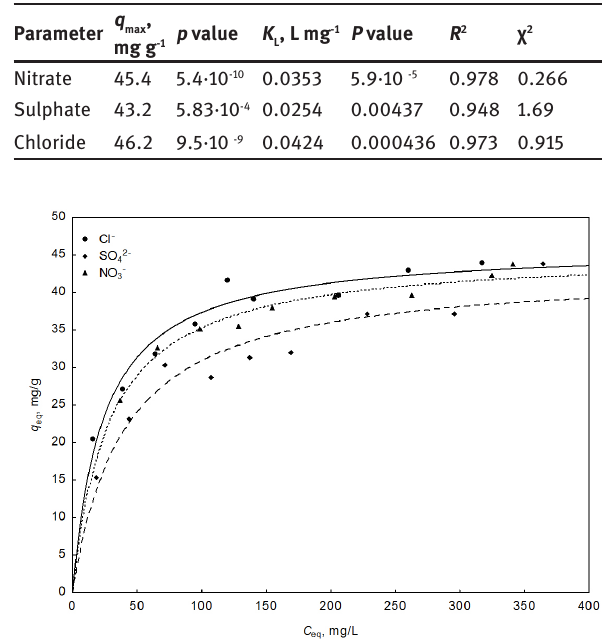
Figure 5: The influence of anion of inorganic salt on biosorption capacity of Co(II) by Chlorella kessleri ( C 25 o C, pH